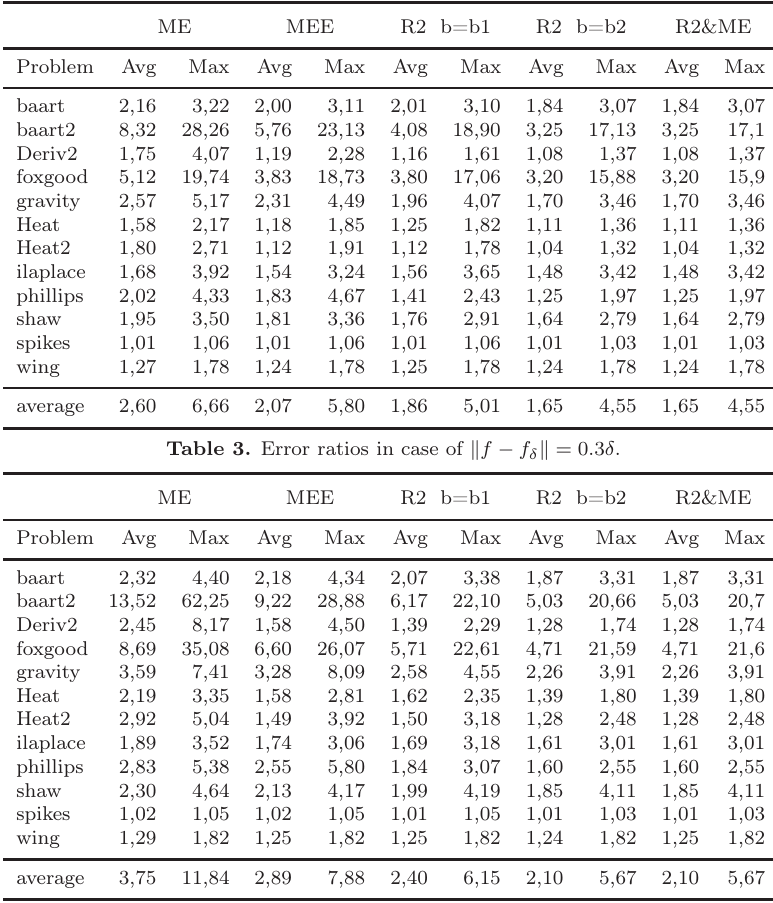
Table 2. Error ratios in case of k f − f δ k = 0 . 7 δ .